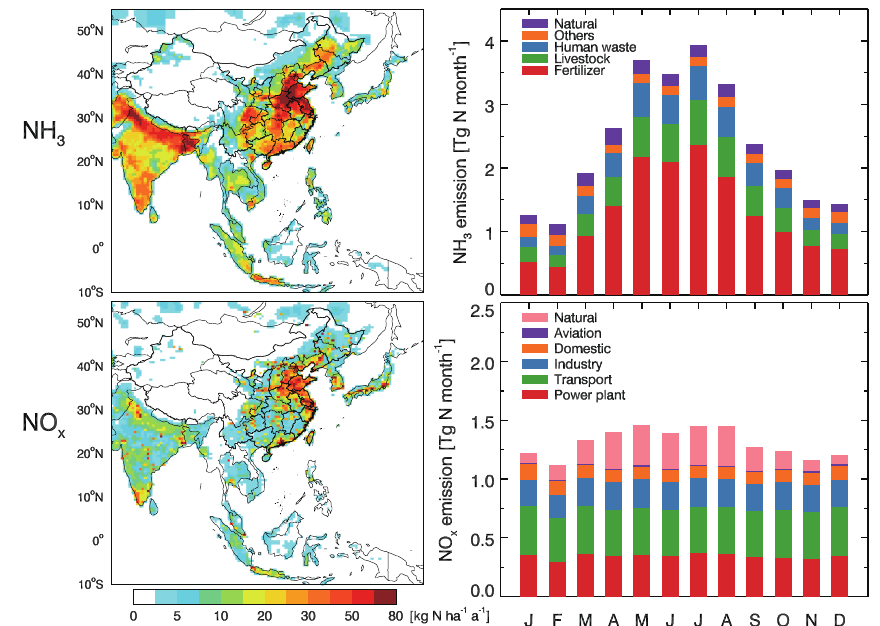
Figure 1. Asian NH 3 and NO x emissions in 2008–2010. The left panels show annual total emissions and the right panels show monthly values of NH 3 and NO x emissions from each source type over Asia.